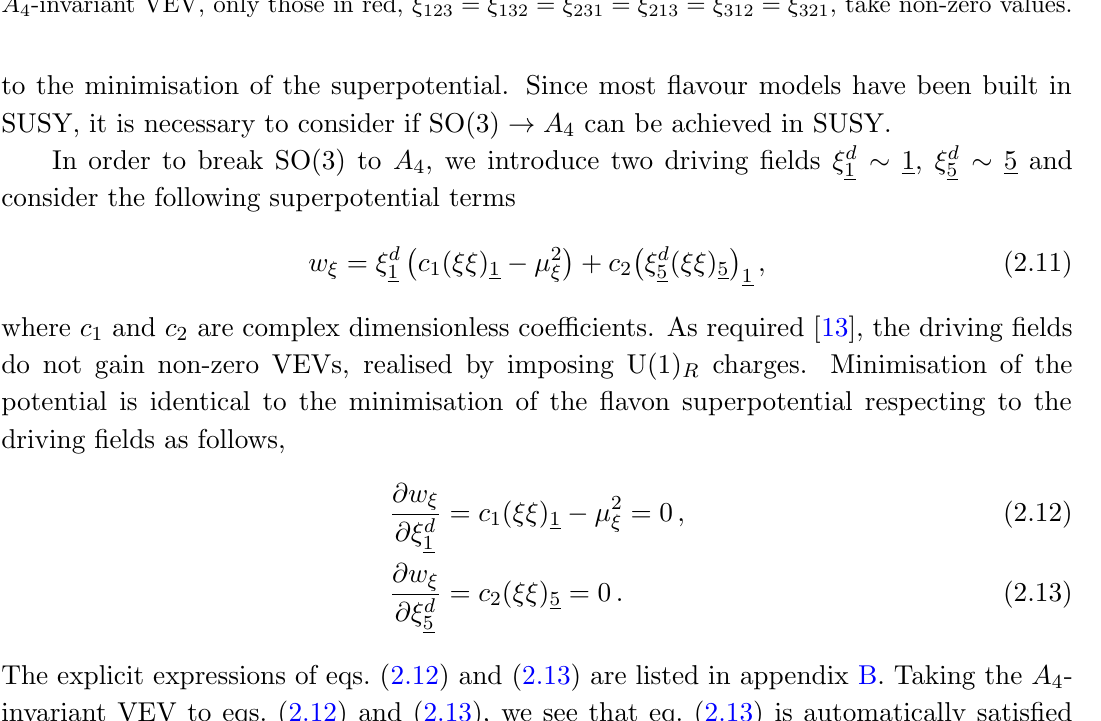
Figure 1 . A geometrical description of the 7-plet (cid:24) ijk as a tank-3 tensor with i; j; k = 1 ; 2 ; 3. Points in the same colour represent the identical components, e.g., (cid:24) 112 = (cid:24) 121 = (cid:24) 211 all in green, etc. As a traceless tensor, points in grey are dependent upon the rest, e.g., (cid:24) 122 = (cid:24) 212 = (cid:24) 221 = (cid:0) (cid:24) 111 (cid:0) (cid:24) 133 . These properties leave only 7 independent components, showing in 7 di(cid:11)erent colours. For the A 4 -invariant VEV, only those in red, (cid:24) 123 = (cid:24) 132 = (cid:24) 231 = (cid:24) 213 = (cid:24) 312 = (cid:24) 321 , take non-zero